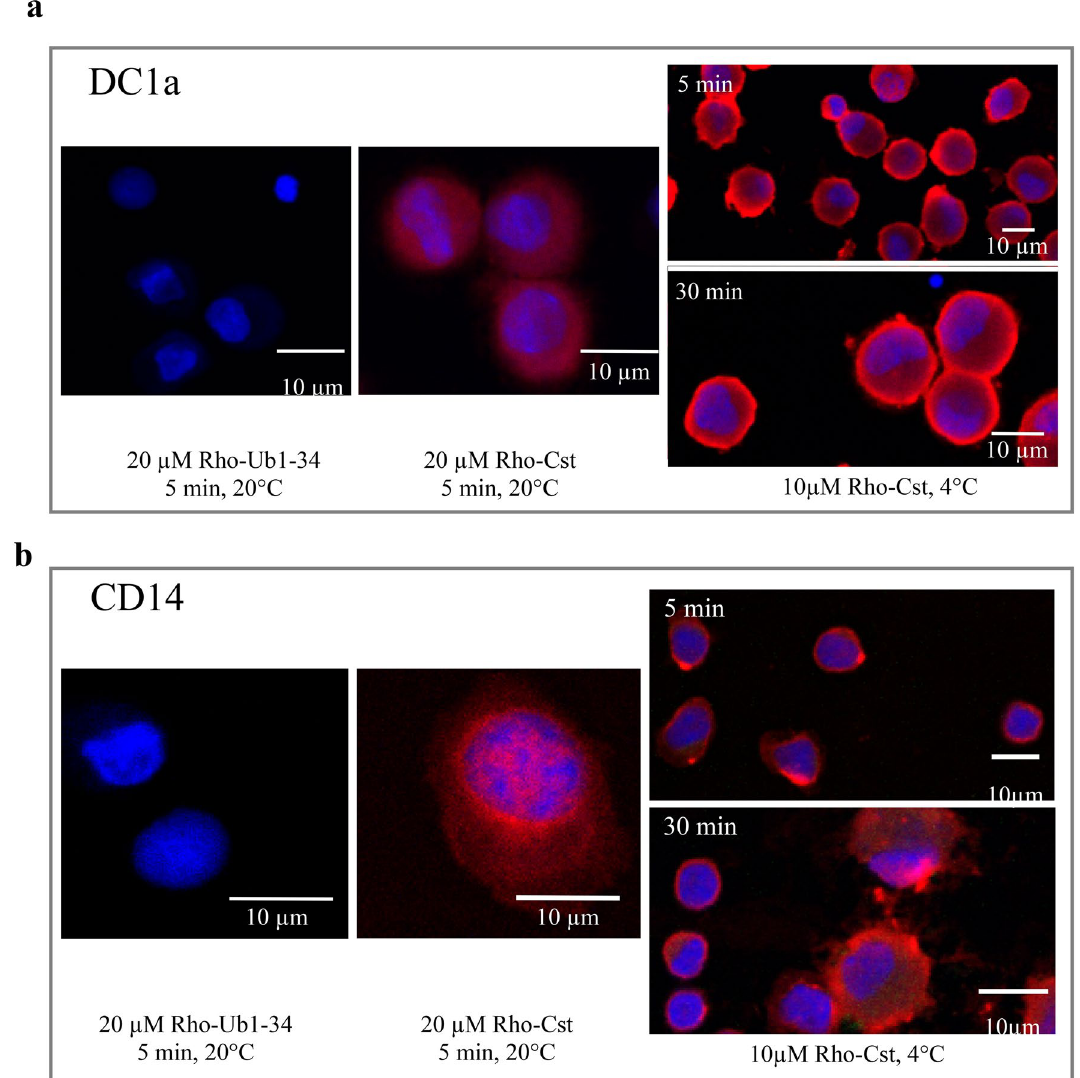
Figure 2. Confocal laser microscope observation of living DC1a ( a ) and CD14 ( b ) cells incubated with rhodamine labeled peptides: 20 µM Rho-Ub1-34 and 20 µM Rho-Cts during 5 min at 20 °C and 10 µM Rho-Cts during 5 min and 30 min at 4